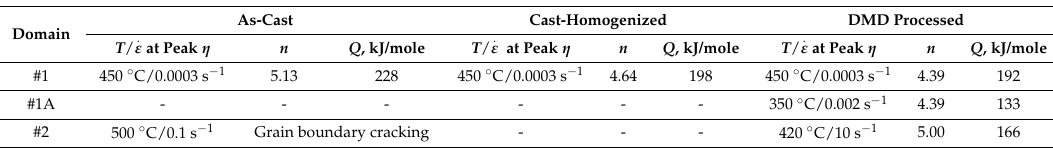
Table 1. Activation parameters in stable domains of processing maps for as-cast, homogenized, and DMD processed AZX312 magnesium alloy.